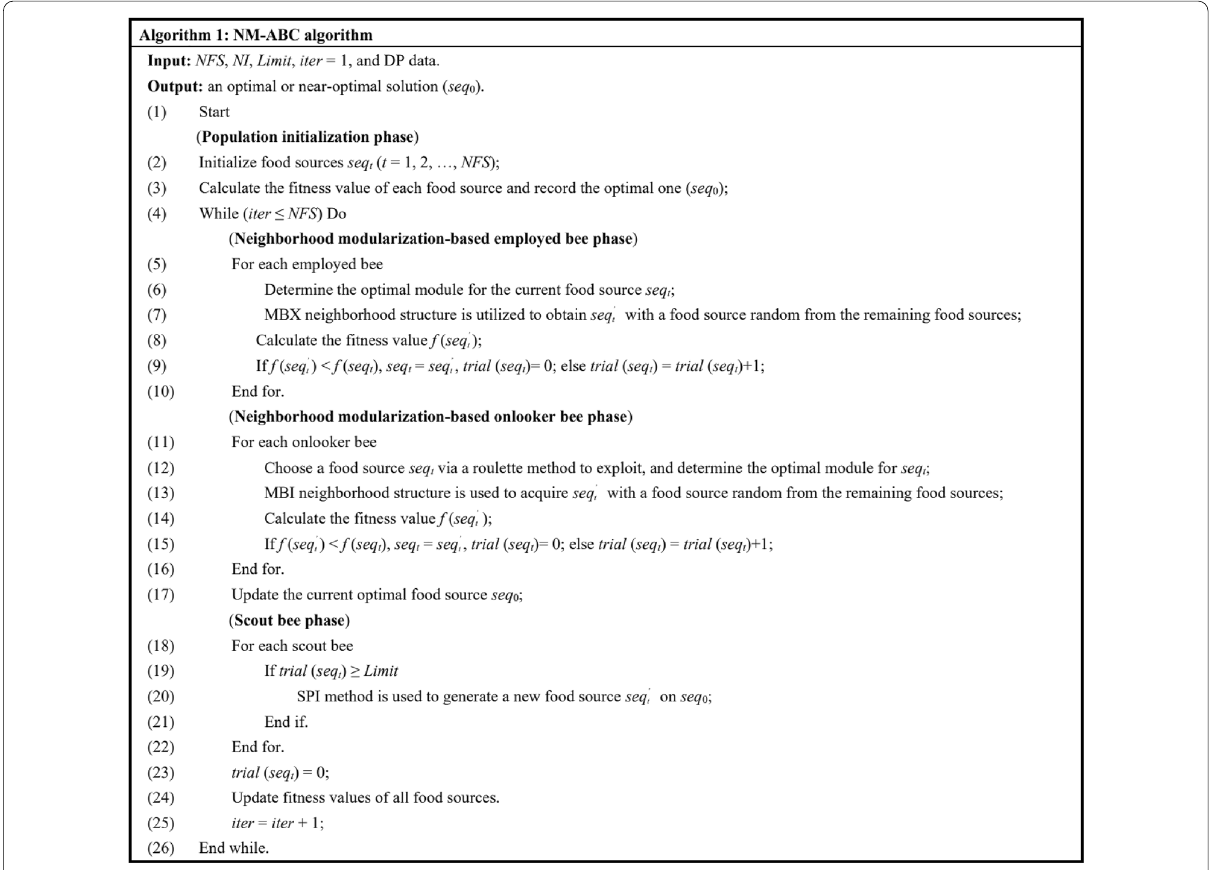
Figure 6 The pseudocode of the NM-ABC algorithm